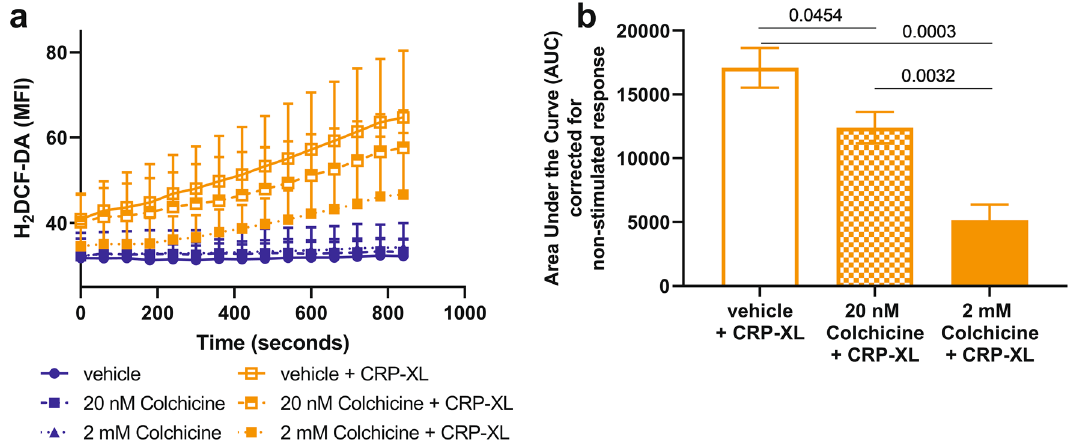
Figure 3. Colchicine inhibits ROS generation in response to GPVI stimulation with CRP-XL. Citrated PRP was used to assess the effect of colchicine on ROS generation, by flow cytometry with H 2 DCF-DA, in response to stimulation of the GPVI receptor with CRP-XL (2 µg/mL) or no agonist control. ( a ) ROS generation was reduced in platelets pre-incubated with colchicine in a concentration dependent manner in response to CRP-XL, no difference was observed between the no agonist controls. ( b ) ROS generation was significantly decreased by 20 nM (p = 0.045, n = 5) and 2 mM colchicine (p = 0.0003)—area under the curve from ( a ) corrected for the non- stimulated response. Statistical significance determined by Students t test; data presented as mean ± SD.